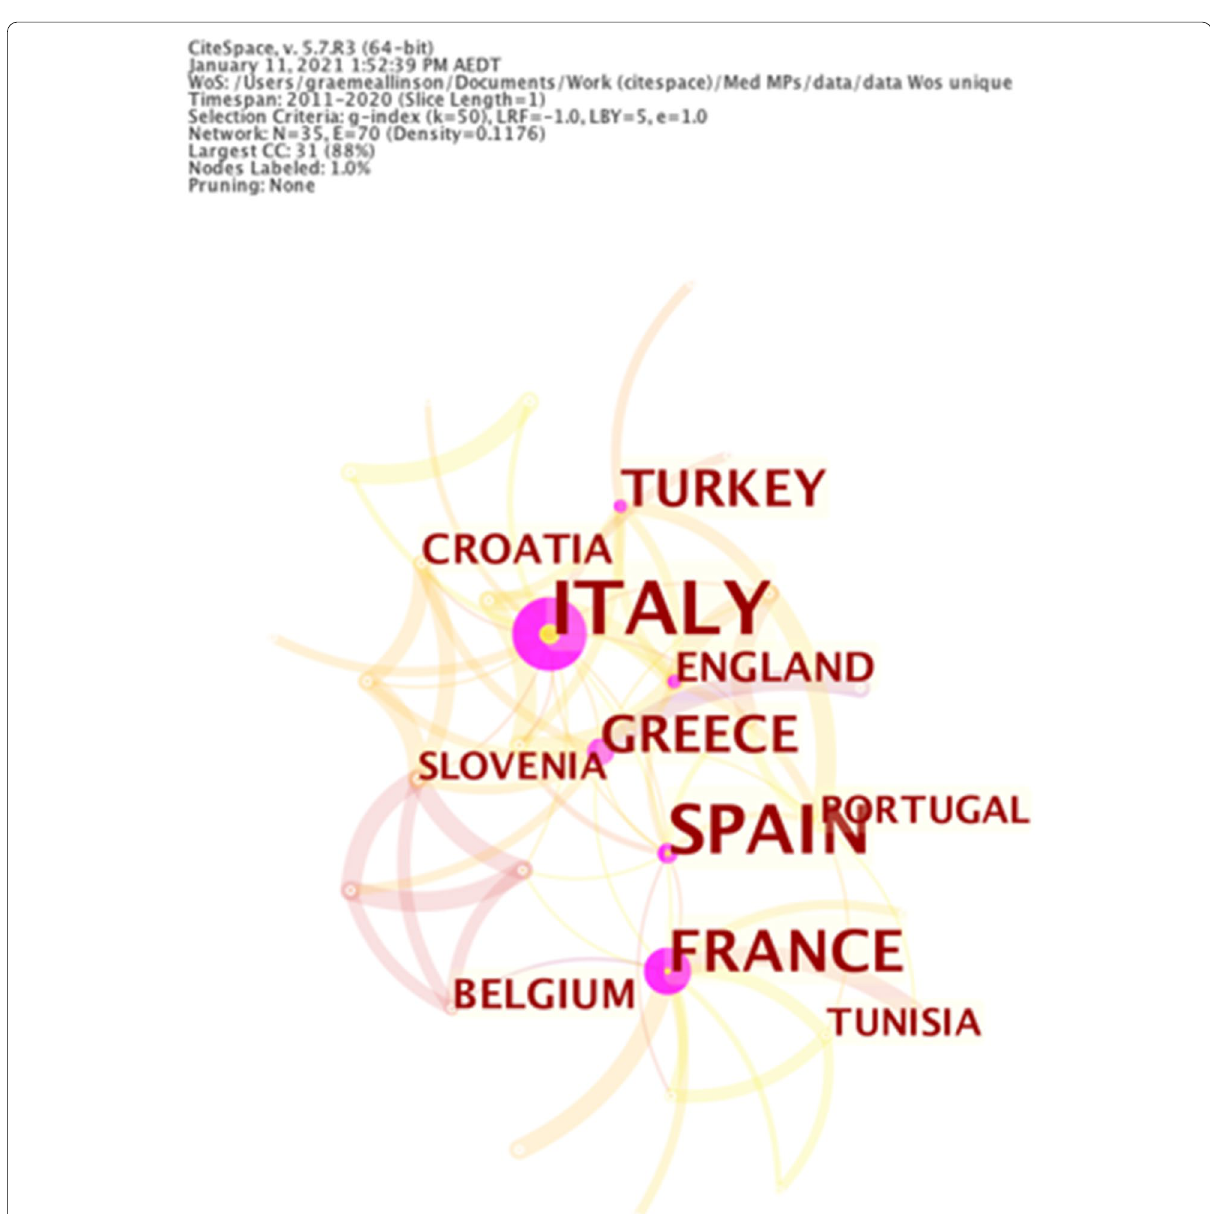
Fig. 2 Distribution of the number of records attributed to authors based in each country: (threshold silhouette 0.8744). Node size signifies the number of papers that originated from the country. Distance between nodes and link thickness = indicates the level of collaboration, link colour indicates earliest period of establishment (purple, oldest; yellow, most recent). Nodes without labels were below the